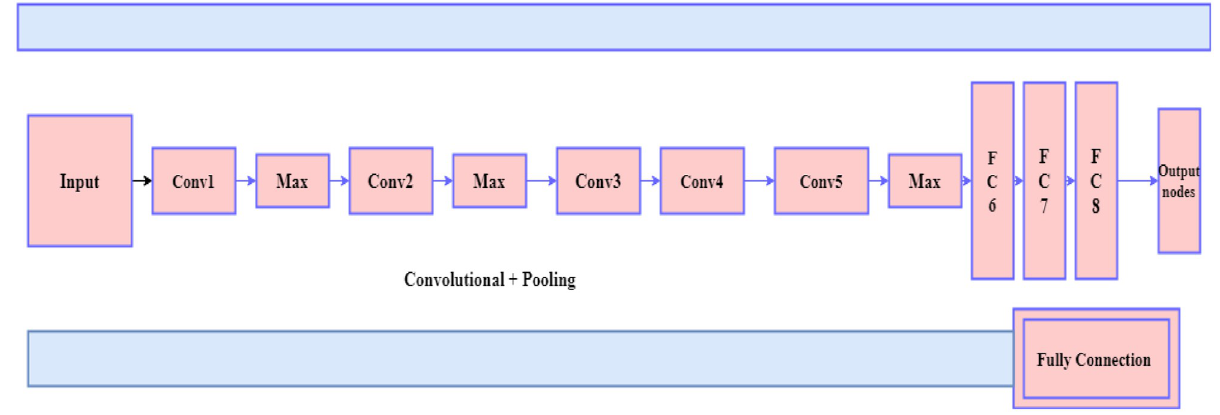
Fig 5. Architecture of the AlexNet